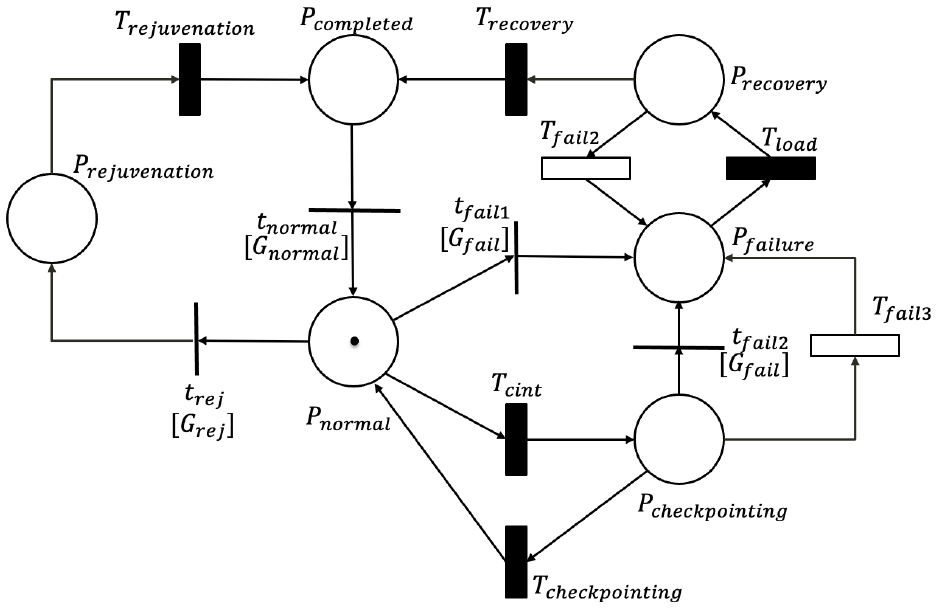
Figure 2. Stochastic (Petri) reward net (SRN) model for system behavior. On the other hand, transitions T cint , T trigger , and T fail 1 correspond to the trigger in- tervals of checkpointing and rejuvenation, and system lifetime, respectively.